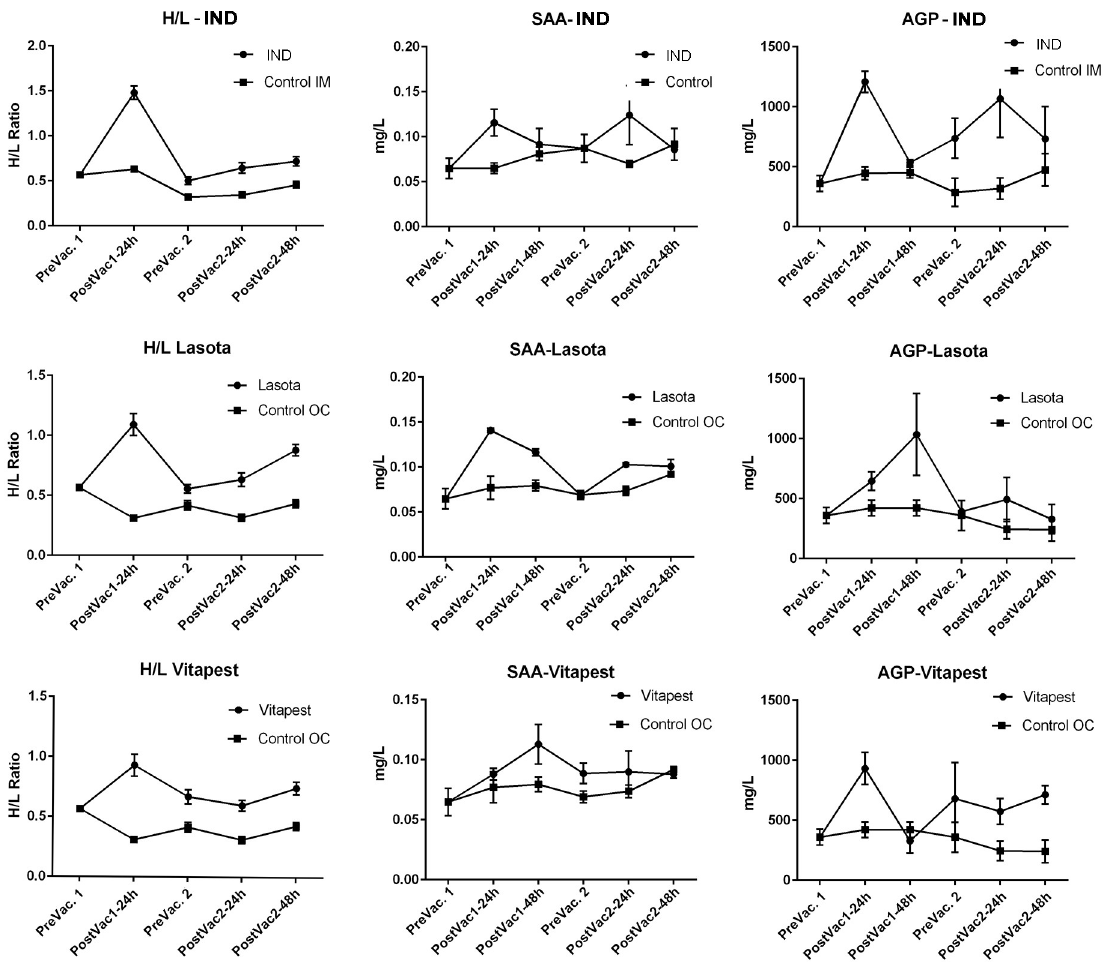
Fig 1. H/L ratio and level of acute phase proteins in responses to vaccination for each time point (n = 10 per time point). Data of sampling time points before first vaccination, day 9 (PreVac.1); after vaccination, days 11 (PostVac1-24h) and 12 (PostVac1-48h); before second vaccination, day 20 (PreVac.2) and after second vaccination, days 22 (PostVac2-24h) and 23 (PostVac1-48h) are presented.